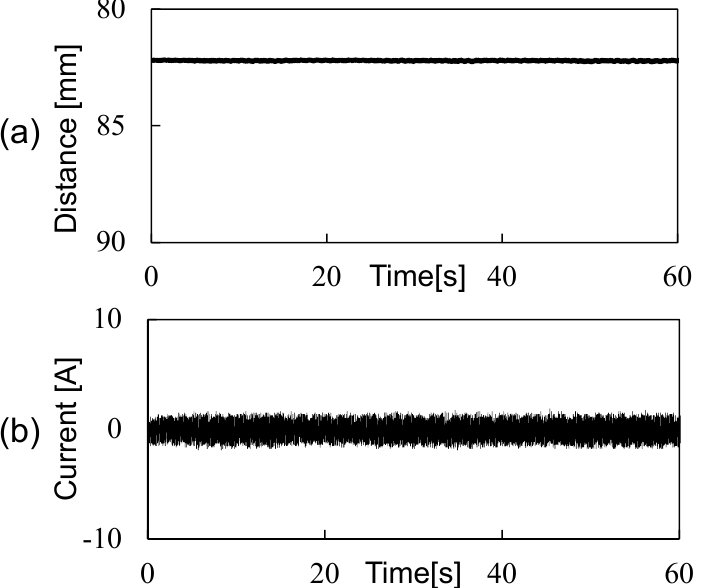
Figure 14. Relationships between ( a ) distance and time and between ( b ) current and time in the case of DC power supplied current.